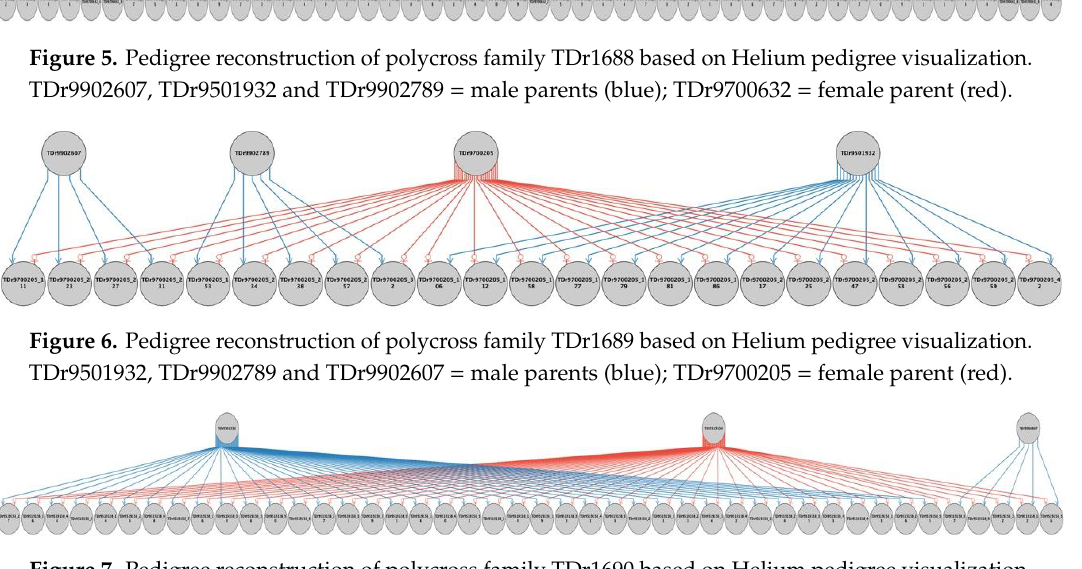
Figure 7. Pedigree reconstruction of polycross family TDr1690 based on Helium pedigree visualization . TDr9501932 and TDr9902607 = male parents (blue); TDr9519158 = female parent (red).